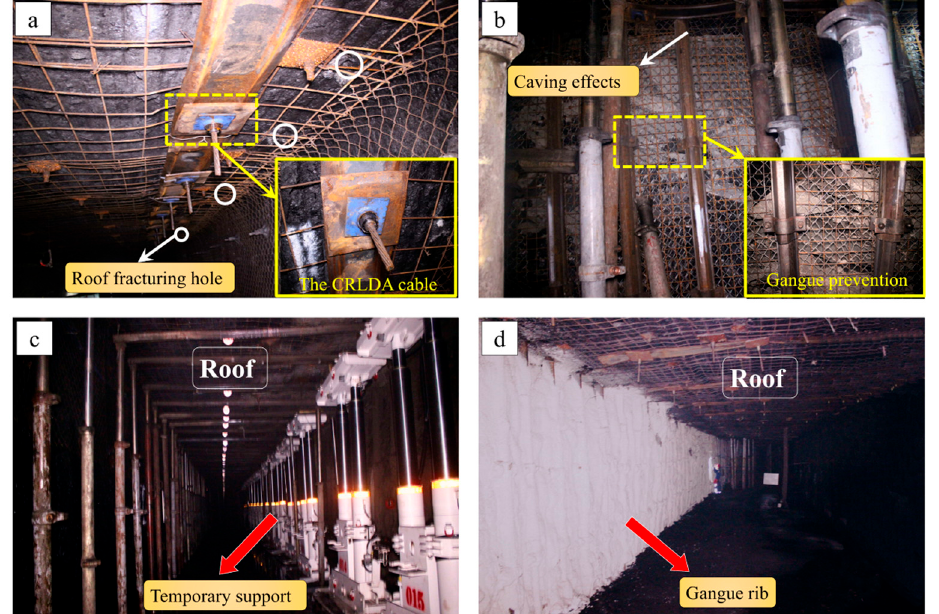
Figure 22. Entry retaining effects with the FRME approach: Photo ( a ) shows the construction effects of the CRLDA cable. Photo ( b ) shows the caving and gangue prevention effects after mining. Photos ( c ) and ( d ) present the cross sections of the retained entry before and after removing the temporary supports, respectively. In photo ( d ), the gangue rib had been blocked up using a high polymer material to prevent gob air leakage.